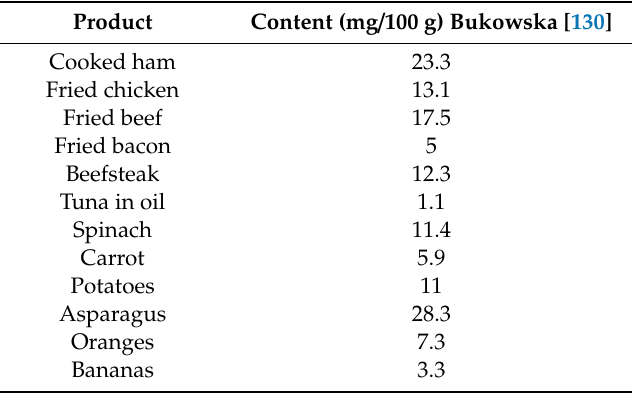
Table 6. Content of glutathione (GSH) in